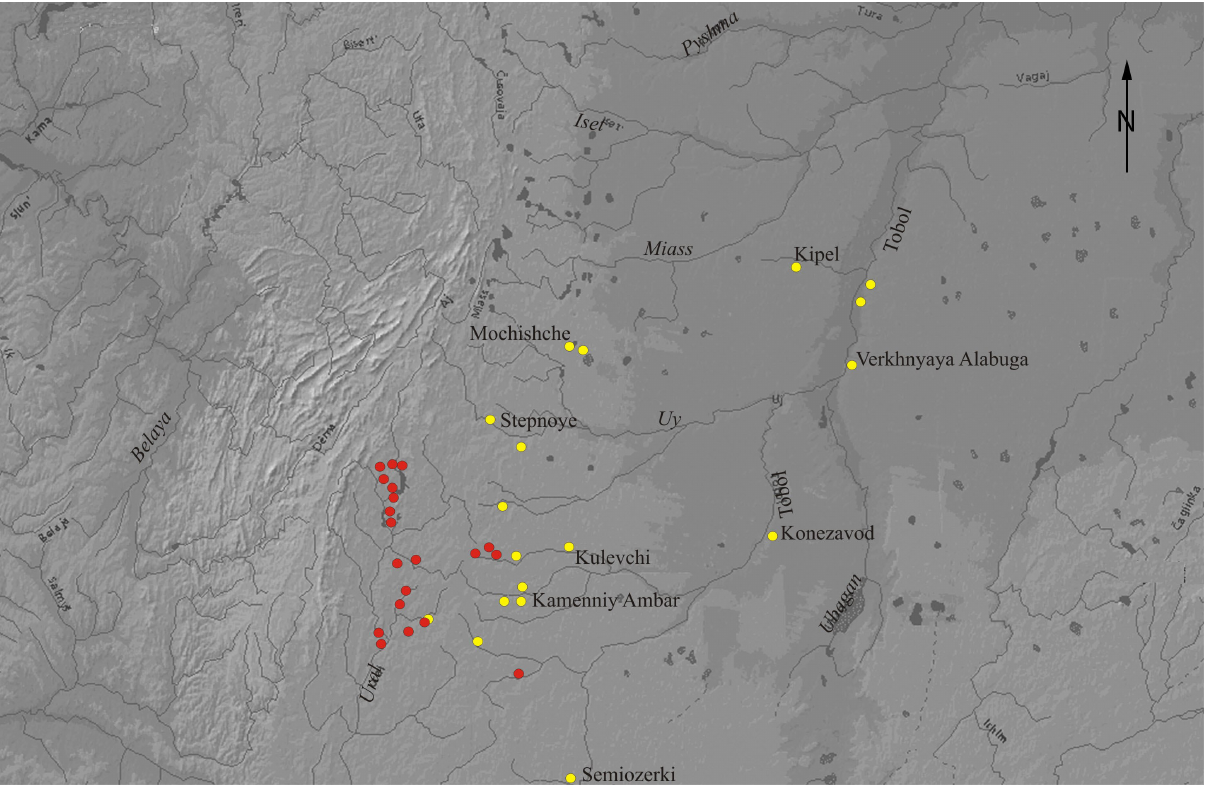
Figure 19: Distribution of Petrovka (yellow circles) and Early Srubnaya and Srubnaya-Alakul (red circles) sites in the Southern Transurals. The border between the steppe and forest-steppe is along the Uy River (after Grigoriev,